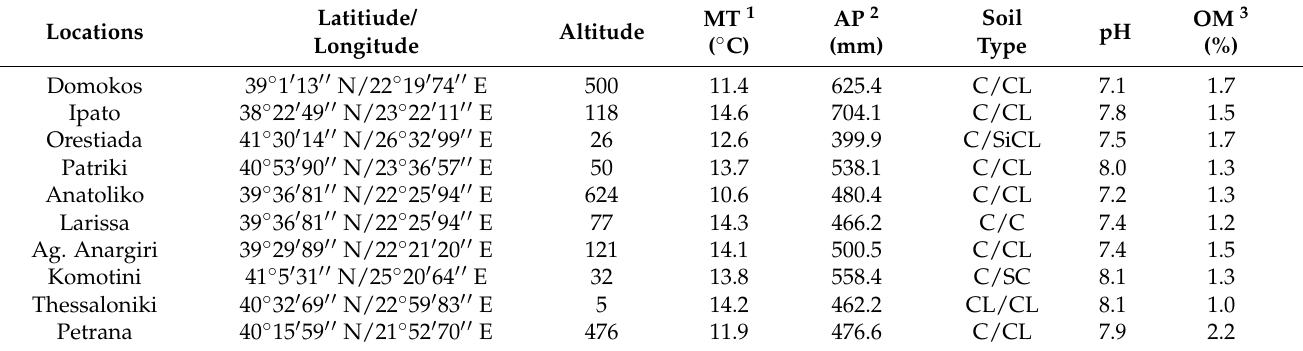
Table 1. Pedoclimatic characteristics of the test